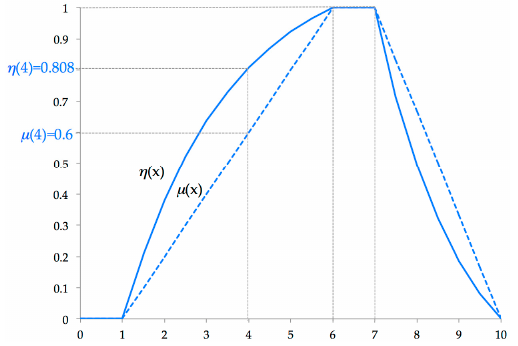
Figure 2. Representation of (cid:2015) ((cid:2868),(cid:2874),(cid:2875),(cid:2869)(cid:2868);(cid:2879)(cid:2870),(cid:2869).(cid:2873)) ((cid:1876)) and (cid:2020)